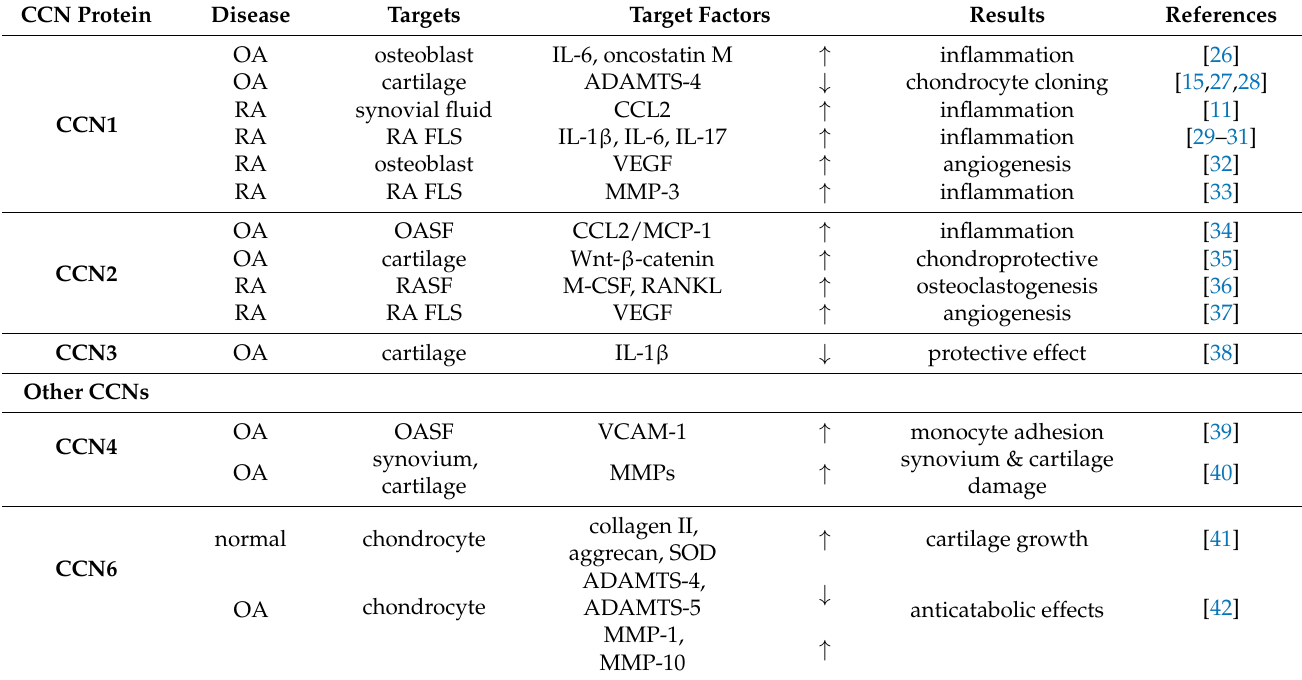
Table 1. Evidence regarding the involvement of CCN proteins in RA and OA. CCN Protein